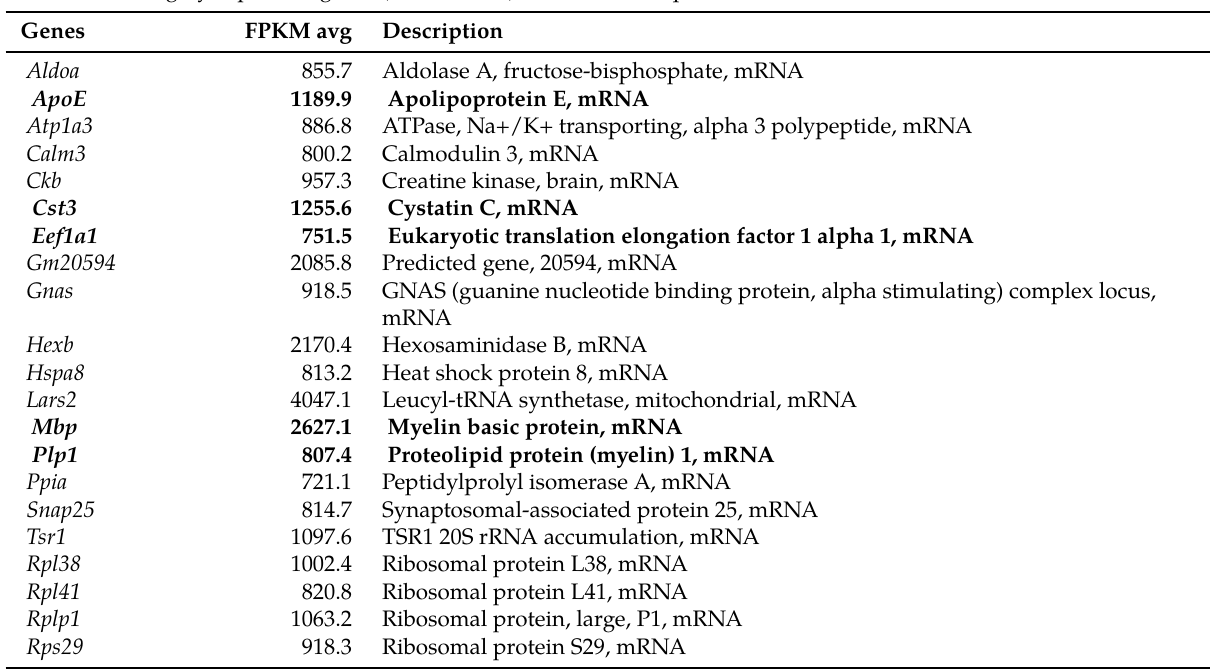
Table 7: Most highly expressed genes (FPKM > 700) in our RNA-Seq data. Genes FPKM avg